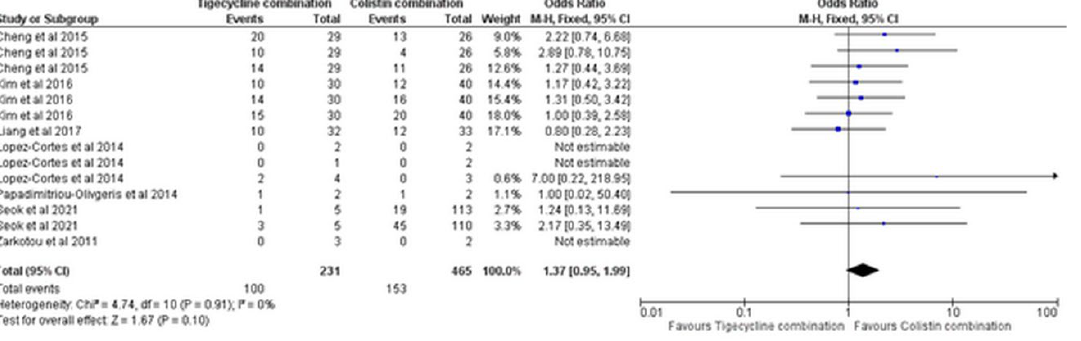
12 of 21 Figure 9. Clinical response of tigecycline combination versus colistin combination [17,20].